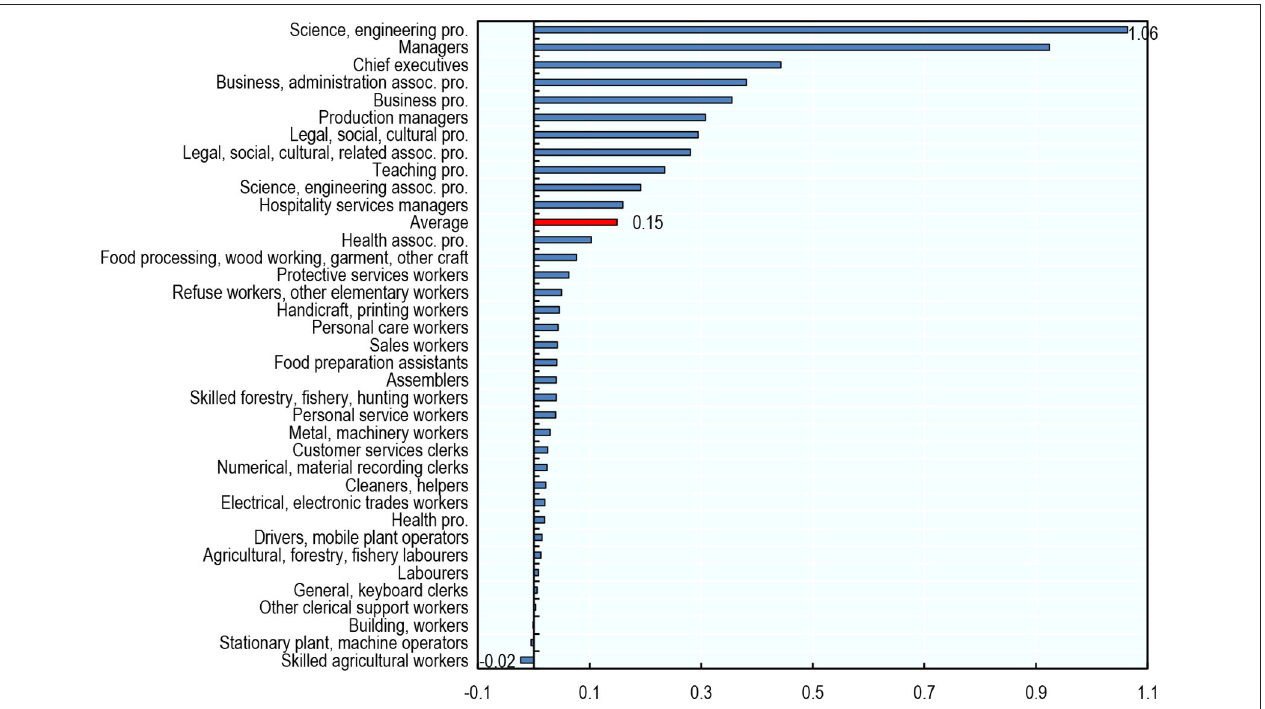
FIGURE 12 | Nearly all occupations have increasingly demanded AI skills between 2012 and 2019 in the United States. Percentage point* change in the share of job postings that require AI skills, 2012–2019, USA. The share of job postings that require AI skills in an occupation is the number of job postings requiring such skills in that occupation divided by the total number of job postings in that same occupation. *Percentage point changes are preferred over percentage changes because the share of job postings that require AI skills is equal to zero in some occupations in 2012. Source: Burning Glass